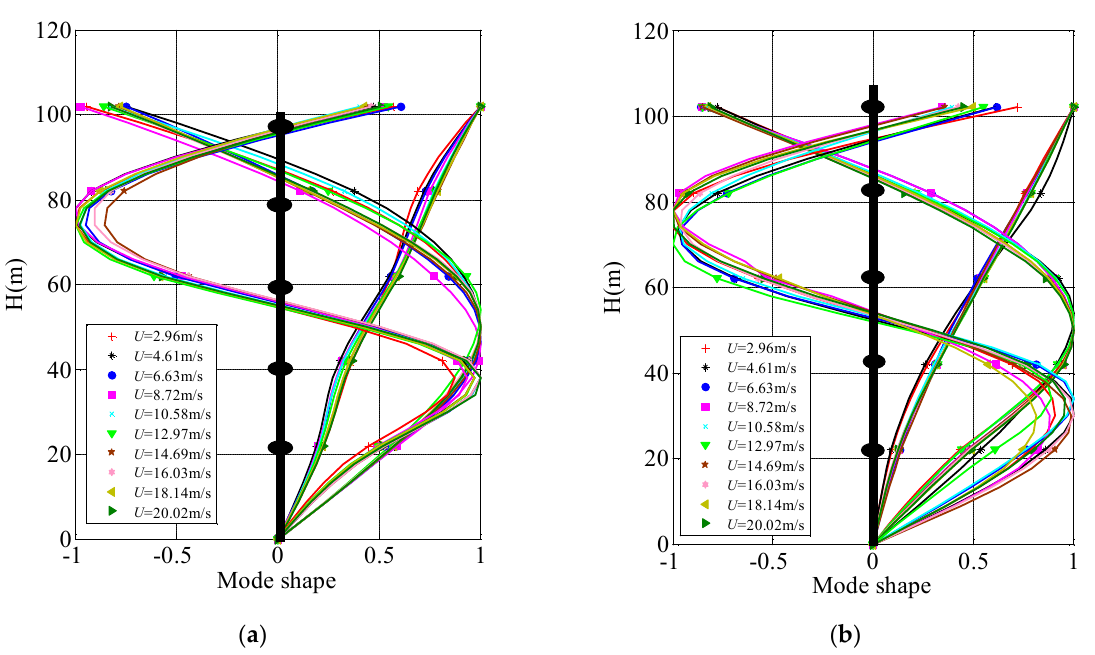
Figure 17. The first three mode shapes along x -and y -axes under different wind speeds. ( a ) along x -axis; ( b ) along y -axis.